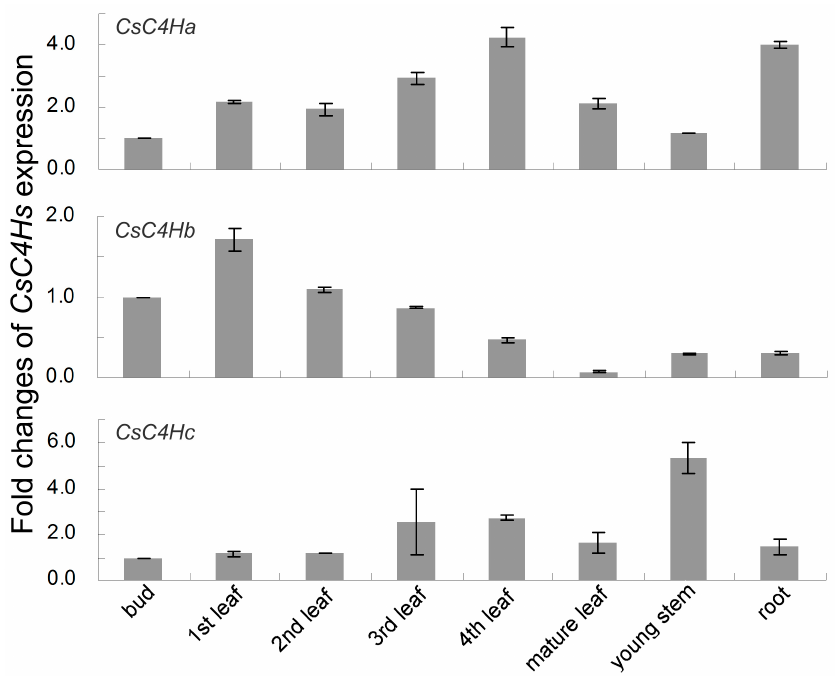
Figure 5. Expression pattern of CsC4H genes in various tissues based on quantitative real-time analysis. The normalized transcripts in the buds were set arbitrarily to one. The data represent the mean standard deviation from three independent measurements.